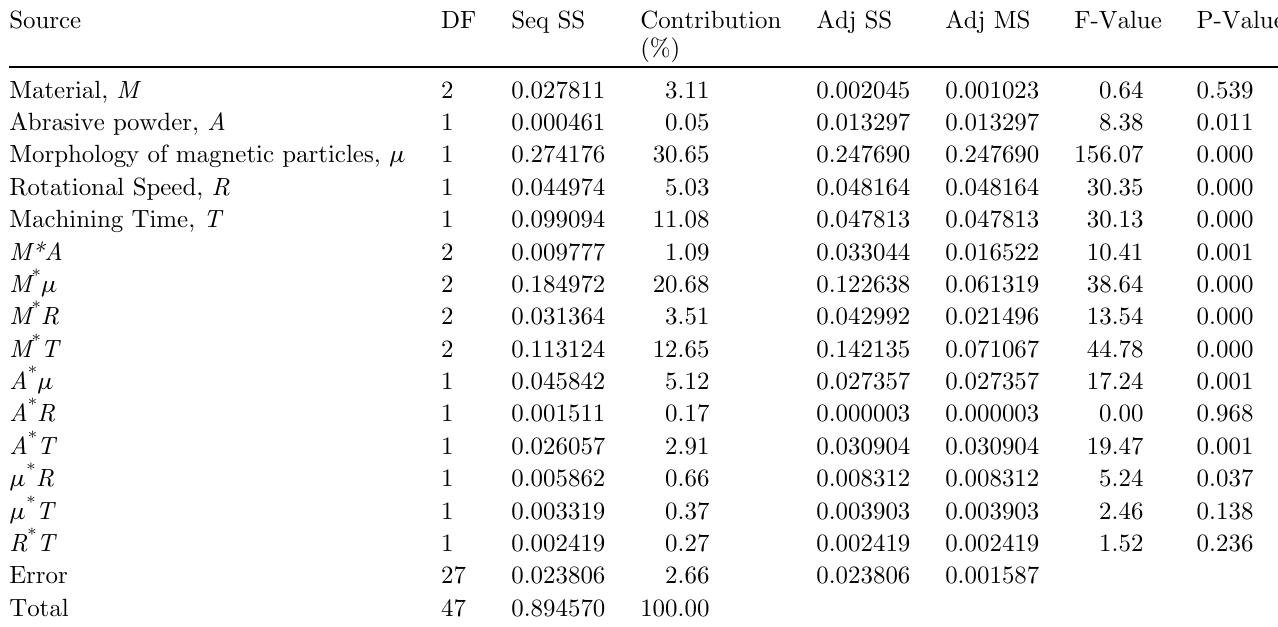
Table 4. Analysis of variance (multi-factor ANOVA) for change in surface roughness ( D R a ).